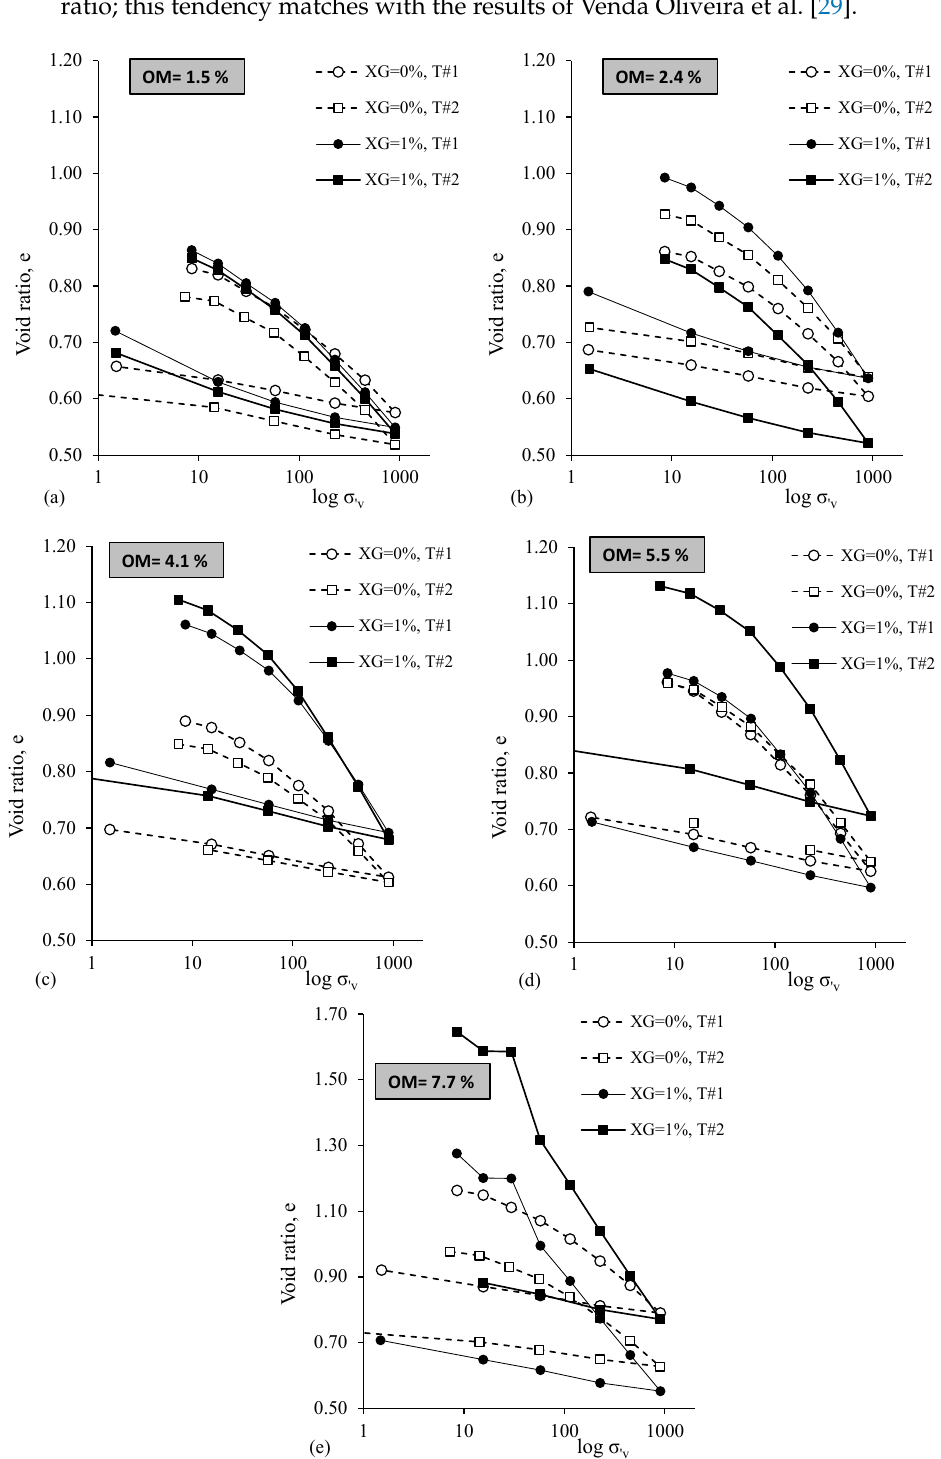
Figure 6. Oedometer tests. Effect of organic matter content on the e-log σ ’ v behavior. ( a ) OM = 1.5%; ( b ) OM = 2.4%; ( c ) OM = 4.1%; ( d ) OM = 5.5%; ( e ) OM = 7.7%.